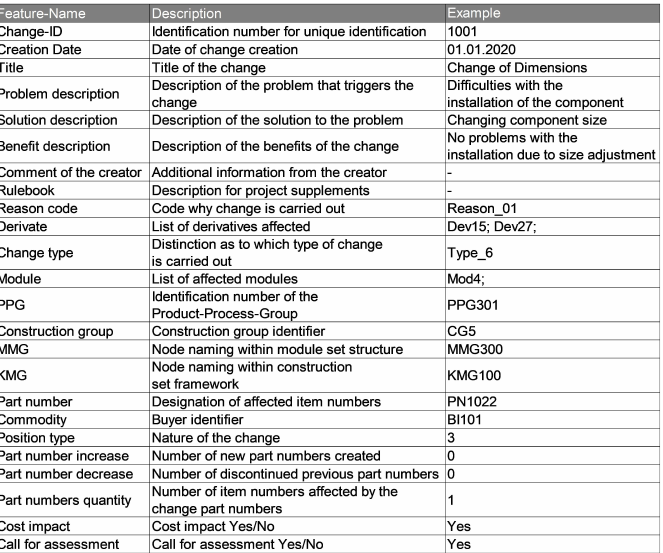
Figure A3. Description of the features in the